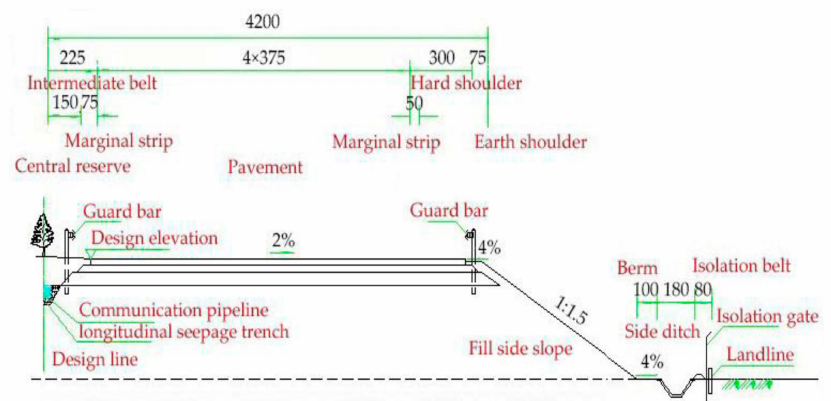
Figure 1. Schematic diagram of a standard subgrade (unit: